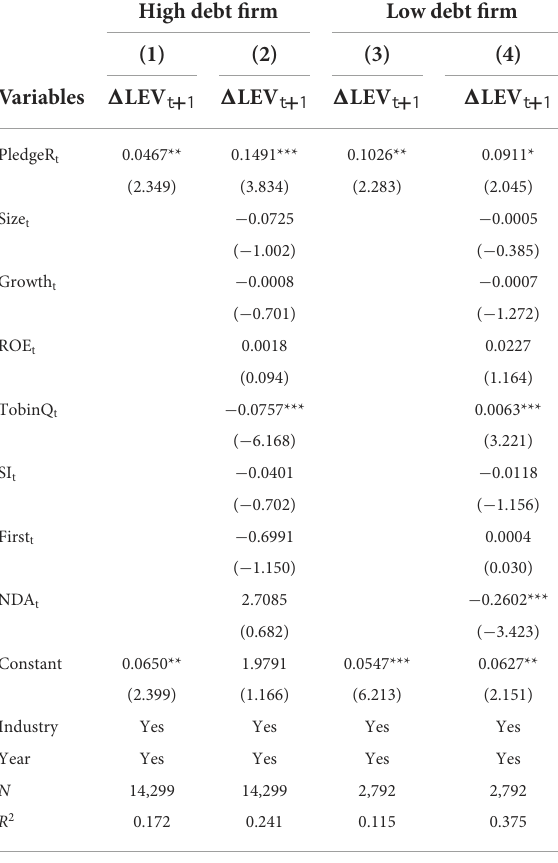
TABLE 5 The association between high leverage of ultimate owner and firm’s financial leverage. High debt firm